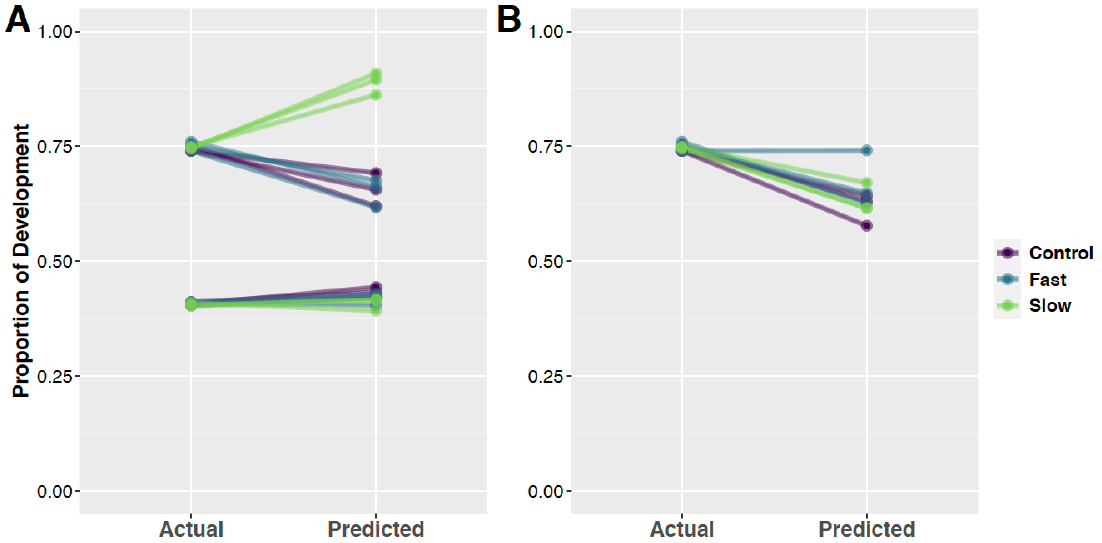
Figure 4. Prediction of the proportion of development completed of development-time-selected samples using a random forest model with all data ( A ) and with two validated miRNA ( B ). ( A ) Random forest models were trained with normalized expression information for miRNA determined to be significantly differentially expressed in larval and intrapuparial development in wild-type C. ma- cellaria . Normalized expression information from larval (bottom) and intrapuparial (top) samples selected for differential development times and their controls were inputted into the model to predict the proportion of development completed. The actual proportion of development completed for each sample is on the left, while the proportion of development predicted to be complete from the random forest model is on the right. Larval samples were predicted with high accuracy. The proportion of development for fast and control intrapuparial samples was slightly underestimated, while the proportion of development for slow-developing samples was overestimated. Actual proportions of development and predictions can be found in Table S8. ( B ) Random forest models were trained on normalized expression of miR-92b and bantam from wild-type samples. This model was used to predict the development time of development-time-selected samples (Fast, Slow, and Control). This model tended to under-predict the development time of the development-time-selected samples by about 10–15 points. While there was an under-prediction, there did not seem to be a large effect of the selection regime, suggesting these markers are more robust to the genotypic variation in these selected lines. These results suggest that fast-developing lines were more accurately